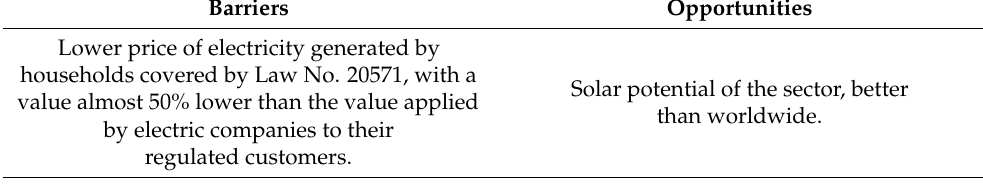
Table 8. Identification of the barriers and opportunities related to the applicability of Law No. 20571 in Arica. Barriers